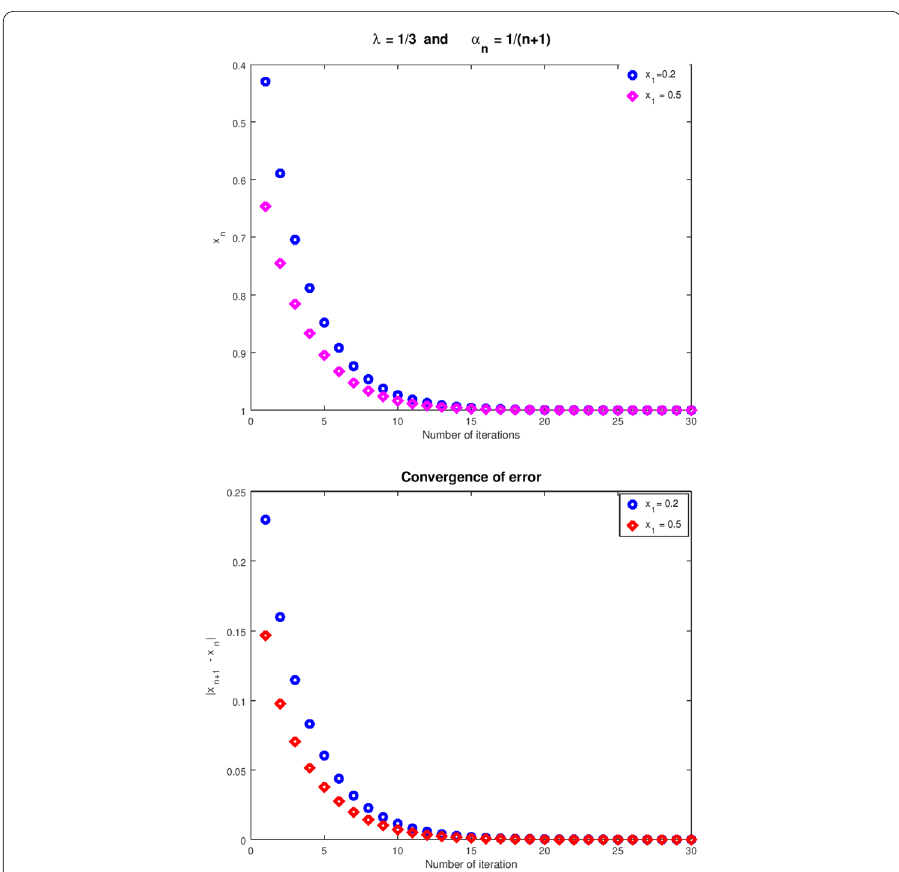
Figure 1 Computational convergence of Algorithm 1 and error term | u n +1 – u n | with the choices of scalars λ = 1 and α n = 1 and different initial points u 1 = 0.2 or u 1 = 3 n +1